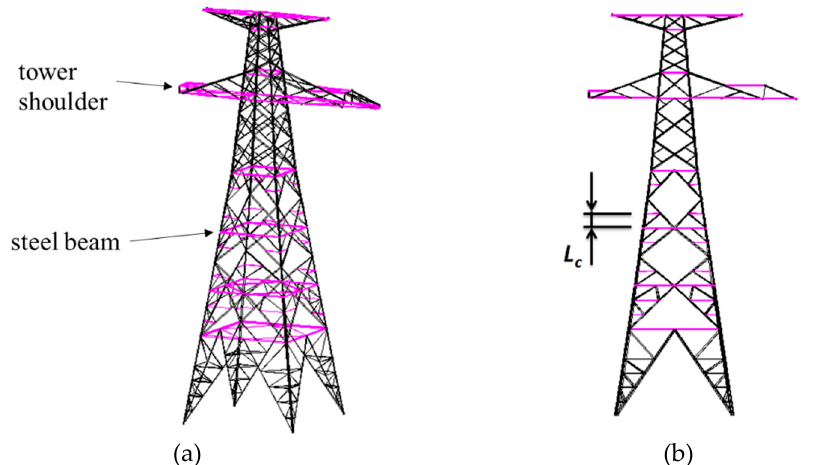
Figure 4. Feature planes of tower body. (a) tower structure; (b) interval between feature plane